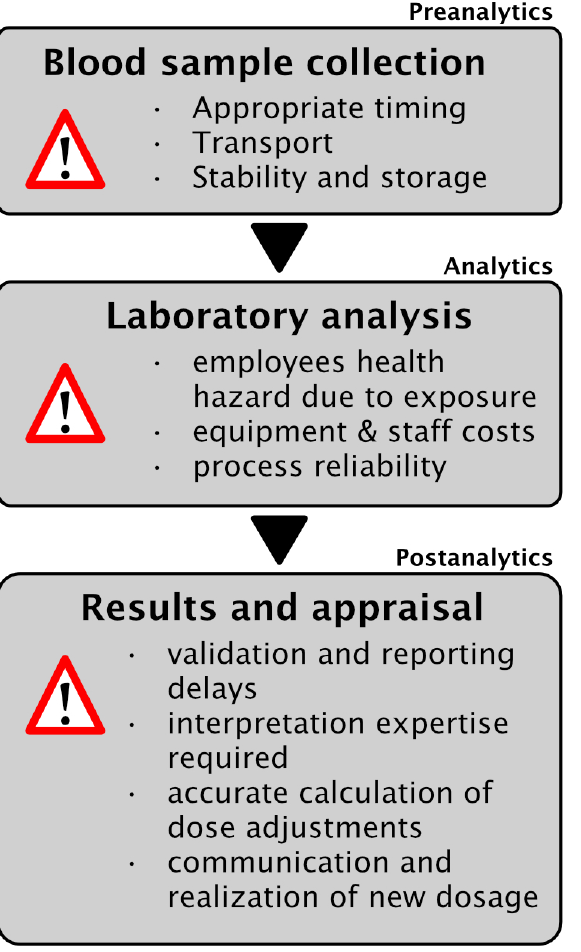
Figure 2. Implemented algorithm for the application of piperacillin/tazobactam and therapeutic drug monitoring of piperacillin at the University Hospital Wuerzburg. Based on the data of this study and the recent literature, we added a potential additional dose regime for critically ill patients with augmented renal clearance, which has to be approved by TDM level evaluation (blue box) [34,37,38].